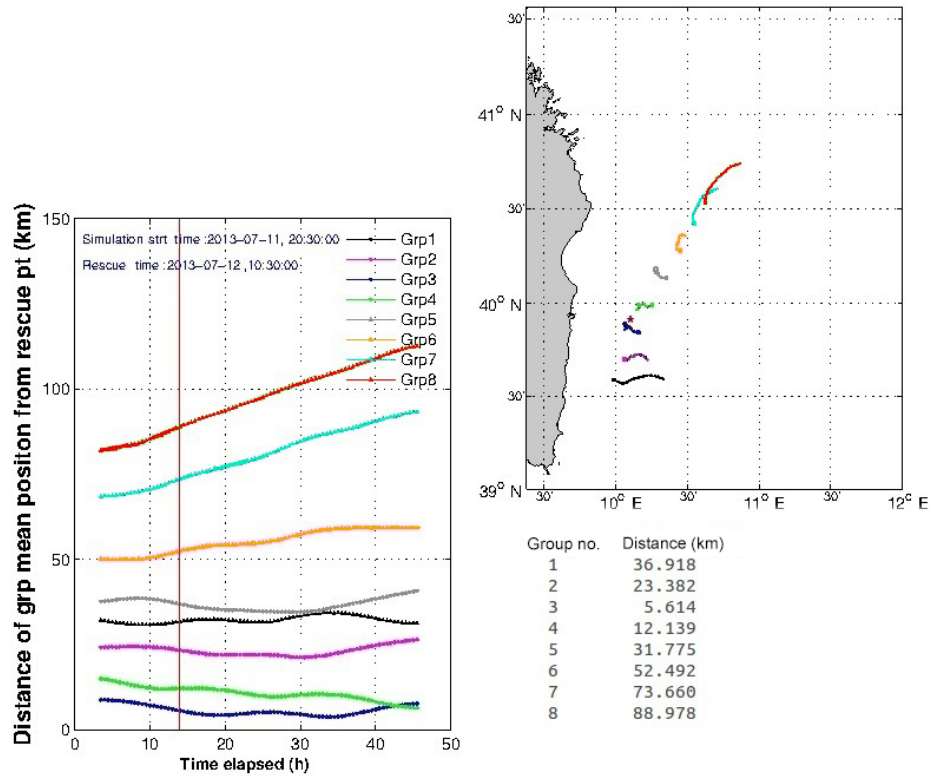
Figure 7. Distance of the mass center of each group planted every 30min from 20:30UTC (group 1) on 11 July 2013 to midnight the following day (group 8), corresponding to the solution in Fig. 6. Now the mass center of the third subset (planted from 21:30 to 22:00UTC) has the smallest distance at the rescue time and it is about 5.6km. The smallest absolute distance is about 4.3km and it is reached 5h later by the same subset of particles. The trajectories of each group’s mass center throughout the simulation seem to have changed slowly with respect to the preceding experiment.